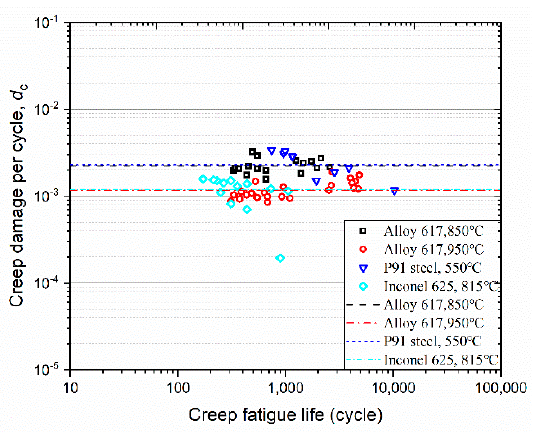
Figure 10. Total damage vs. creep-fatigue life.